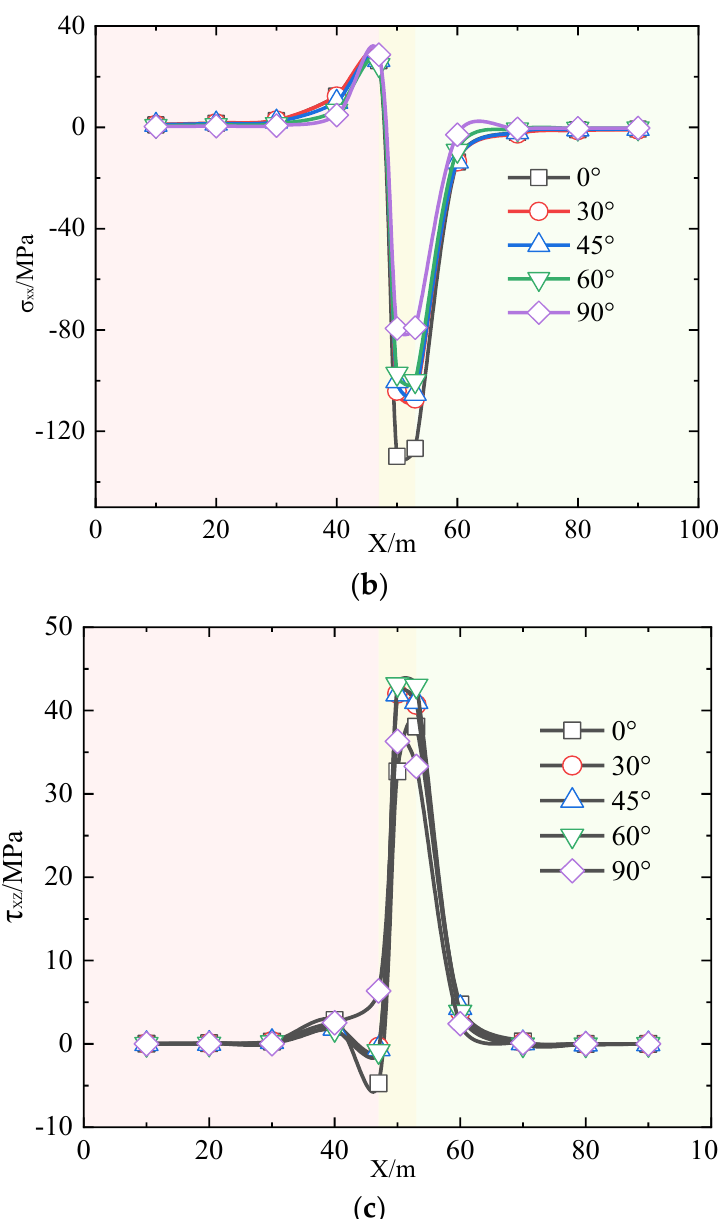
Figure 13. Analytical results for different values of formation dip. ( a ) vertical stress, ( b ) horizontal stress, ( c ) shear stress.